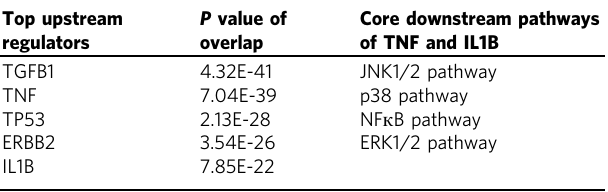
Table 2 Analysis of enriched upstream regulators and its core downstream pathways Top upstream